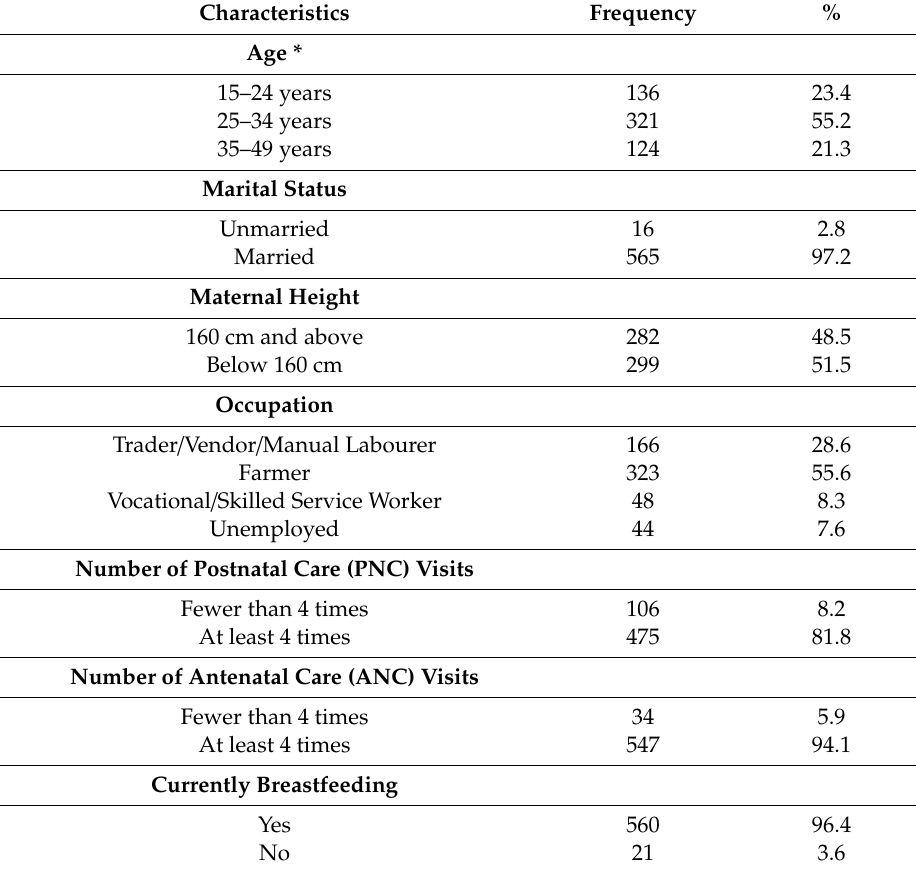
Table 1. Maternal characteristics ( n =